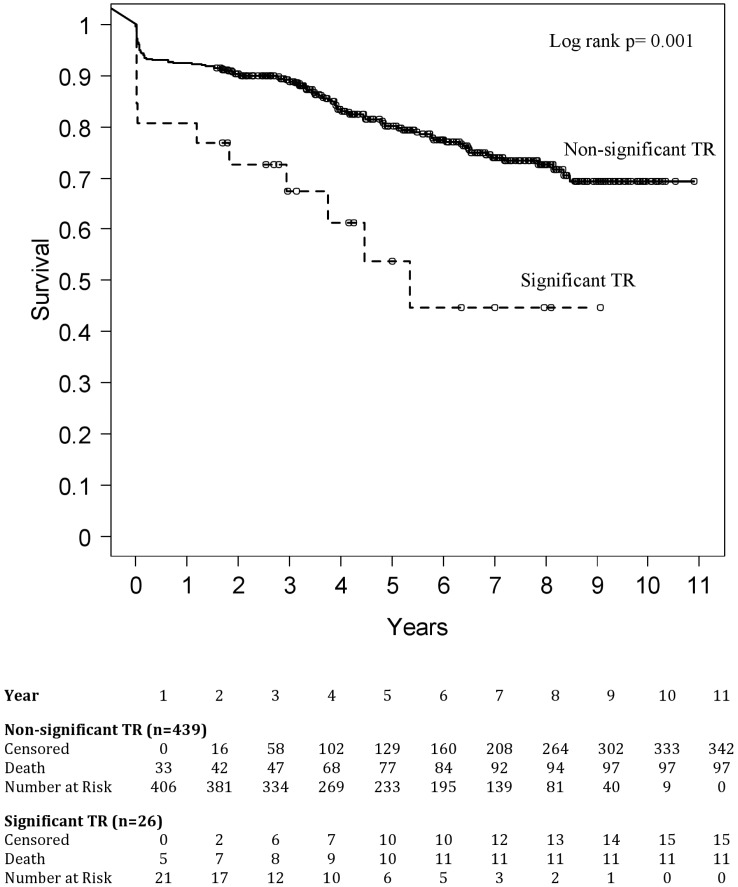
Overall survival in patients with versus without significant TR.TR indicates tricuspid regurgitation.